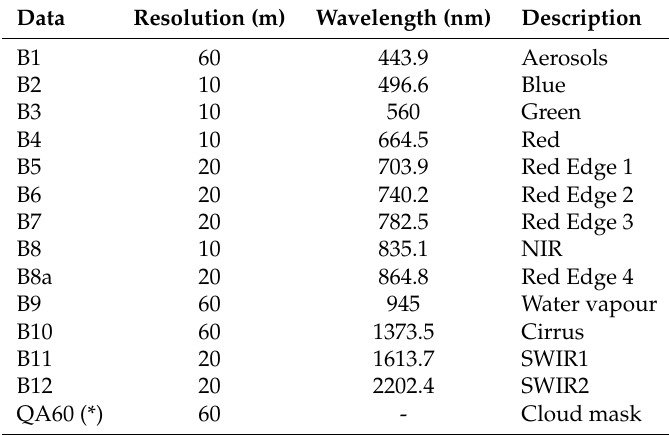
Table 4. Sentinel-2 band information used in this study, obtained from [24]. (*) Band QA60 has not been used as input for the Neural